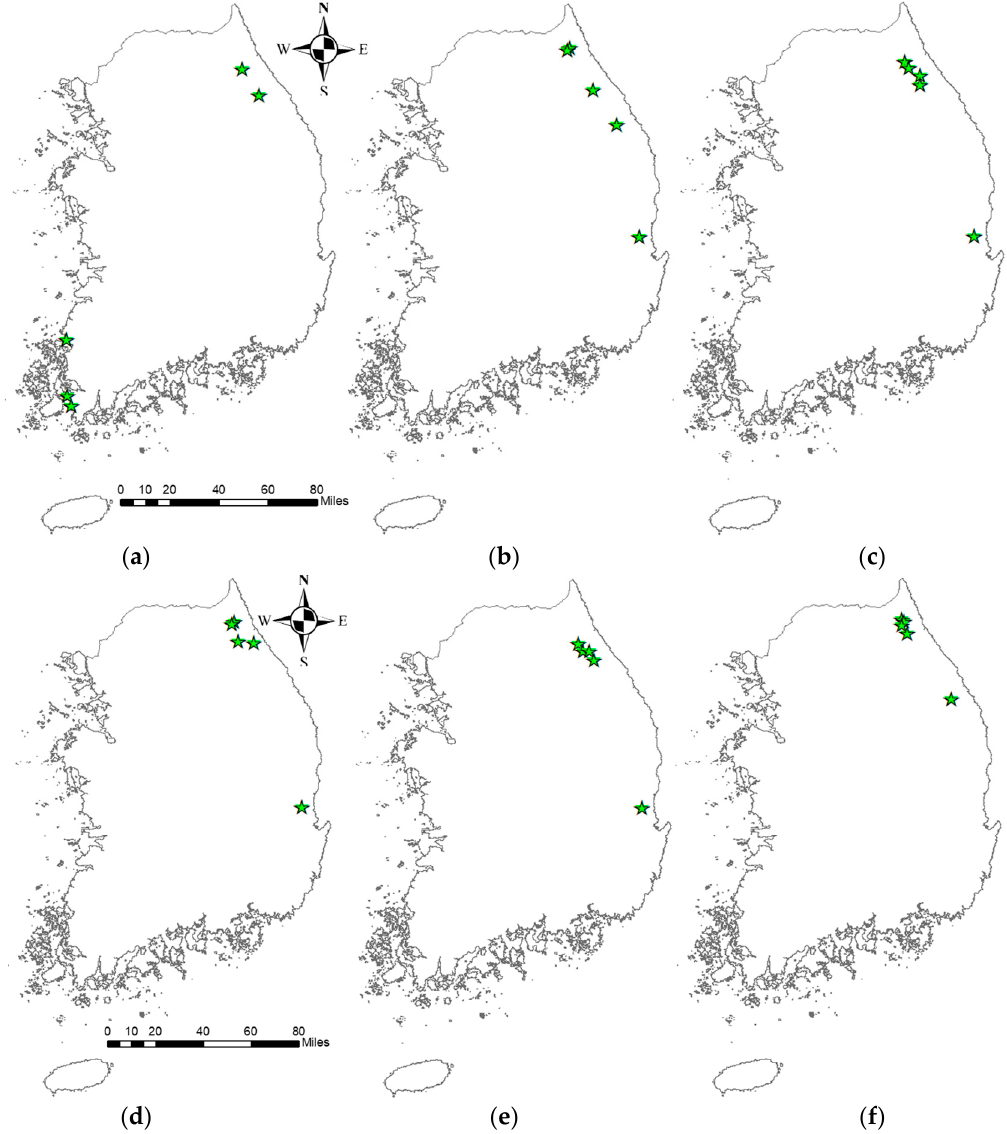
Figure 9. Top 5 most suitable wind farm sites excluding restricted areas ( a ) Scenario 1 ( b ) Scenario 2 ( c ) Scenario 3 ( d ) Scenario 4 ( e ) Scenario 5 ( f ) Scenario 6.